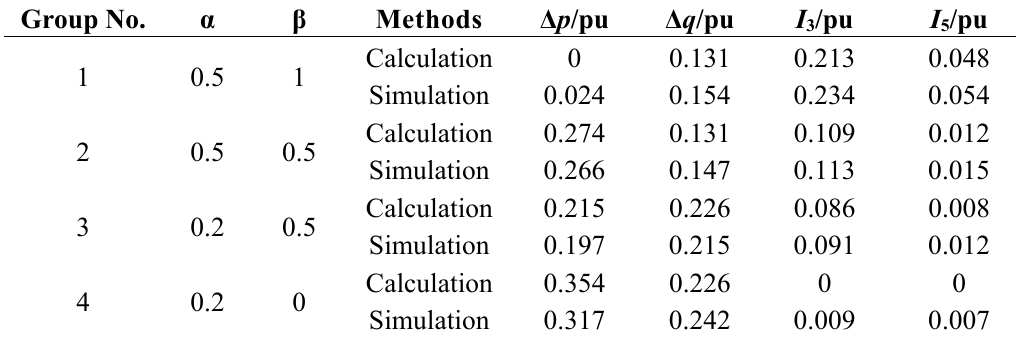
Table 2. Comparison between calculation and simulation results under different adjustment coefficient